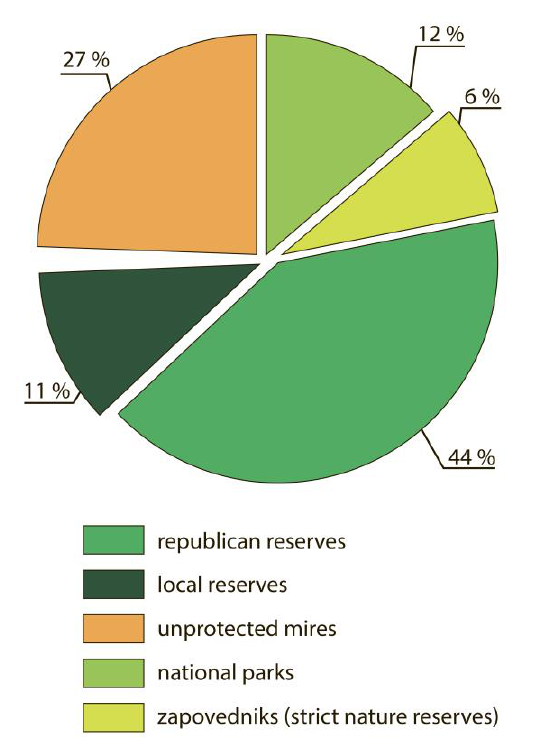
Figure 2. The current state of peatlands in Belarus according to SPBC (2016).